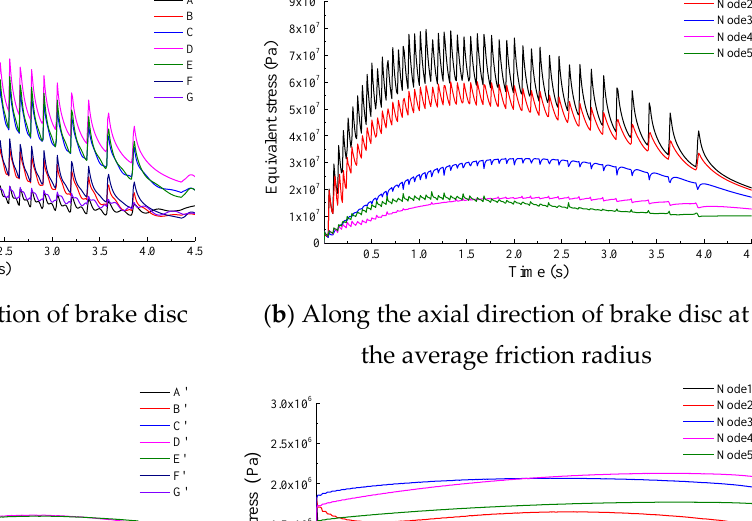
Figure 9. Equivalent Von Mises stress distributions of brake disc and brake shoe along radial and axial